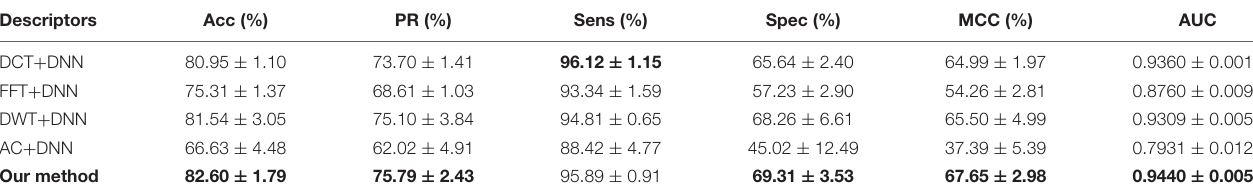
TABLE 6 | Performance comparison of the DHT with different feature extraction methods on Oryza sativa dataset.